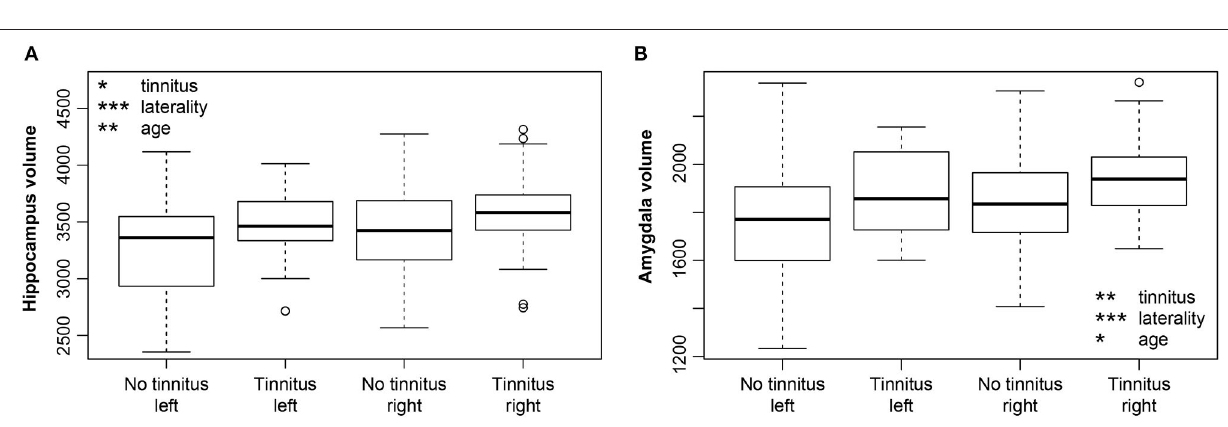
FIGURE 7 | (A) Increase of the hippocampus volume due to tinnitus. Hippocampus is larger in the right hemisphere (laterality). (B) Increase of the amygdala volume due to tinnitus. Amygdala is larger in the right hemisphere (laterality). Volume of both structures decreases with age. * p < 0.05, ** p < 0.001, *** p < 0.0001